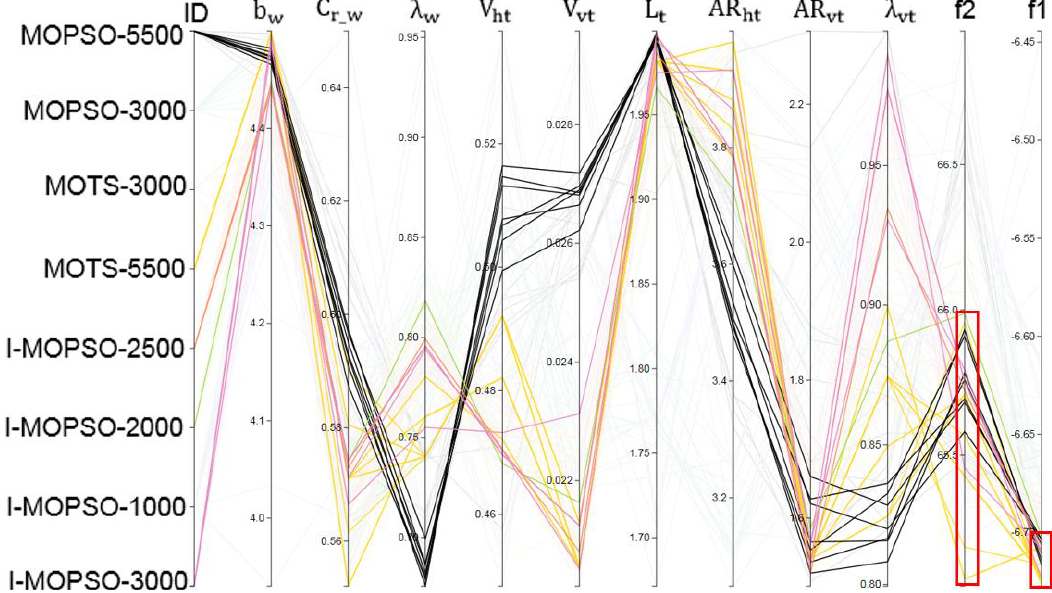
Figure 20. Optimisation case able to satisfy the Decision Maker’s (DM’s) interest. For the region of interest see the red rectangles on f1 and f2. ID represents the various optimisation scenarios, e.g., MOPSO-5000.